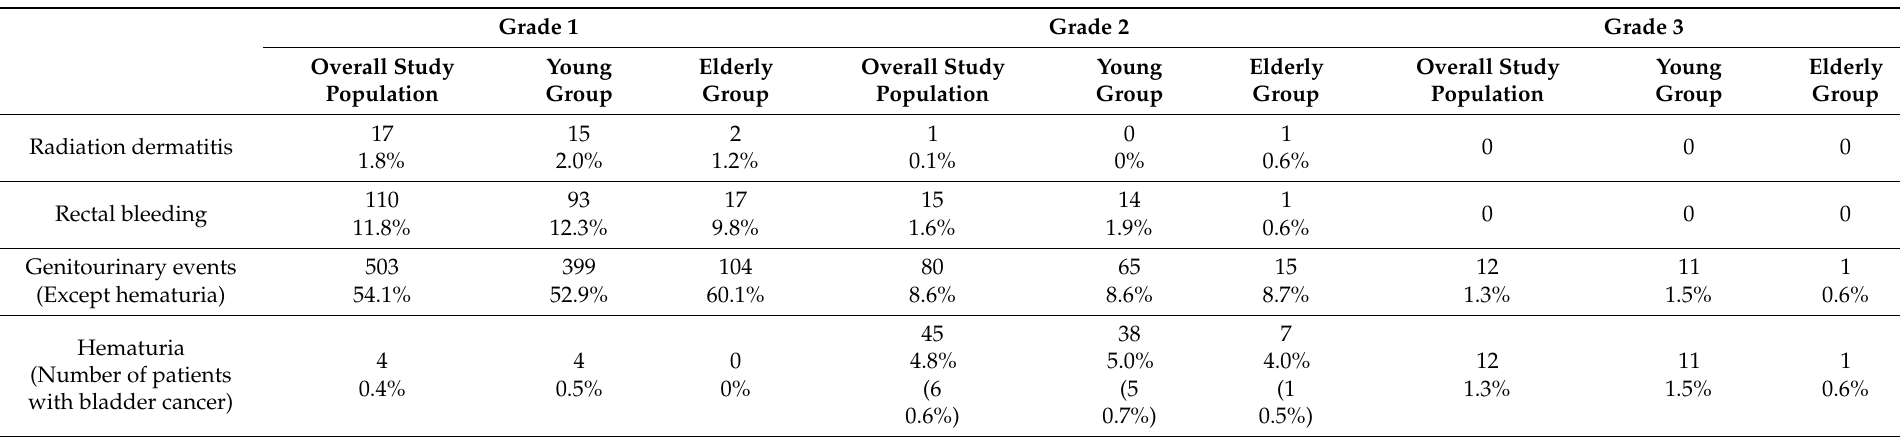
Table 2. Adverse events after carbon-ion radiotherapy in patients with high-risk prostate